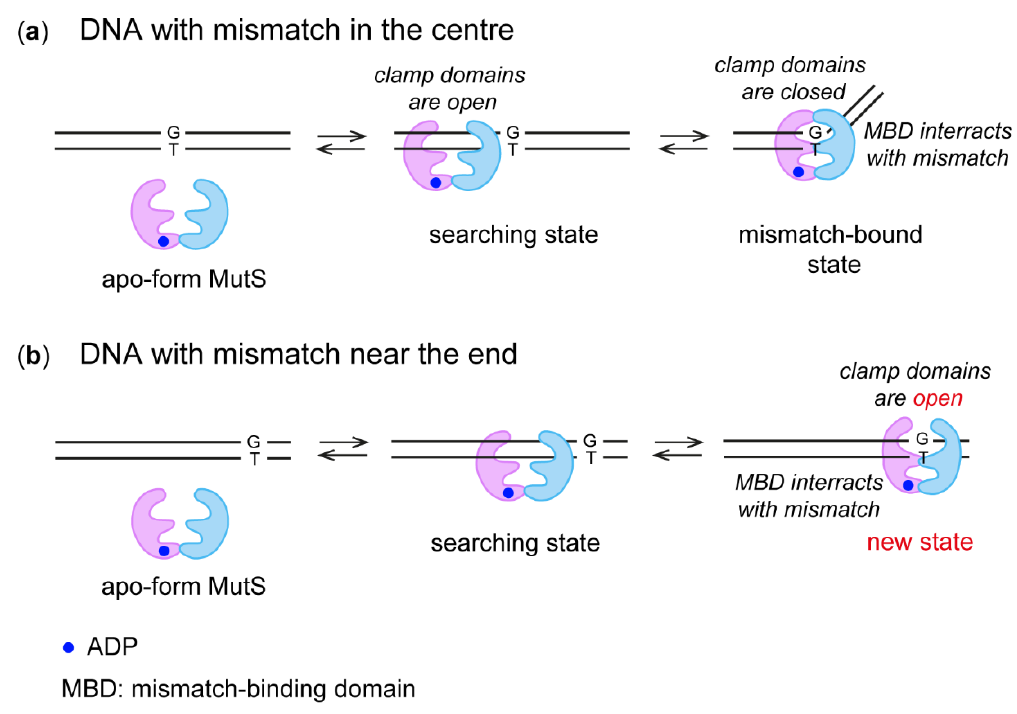
Figure 8. MutS binding to DNA with a mismatch in the middle ( a ) or near a terminus of the duplex ( b